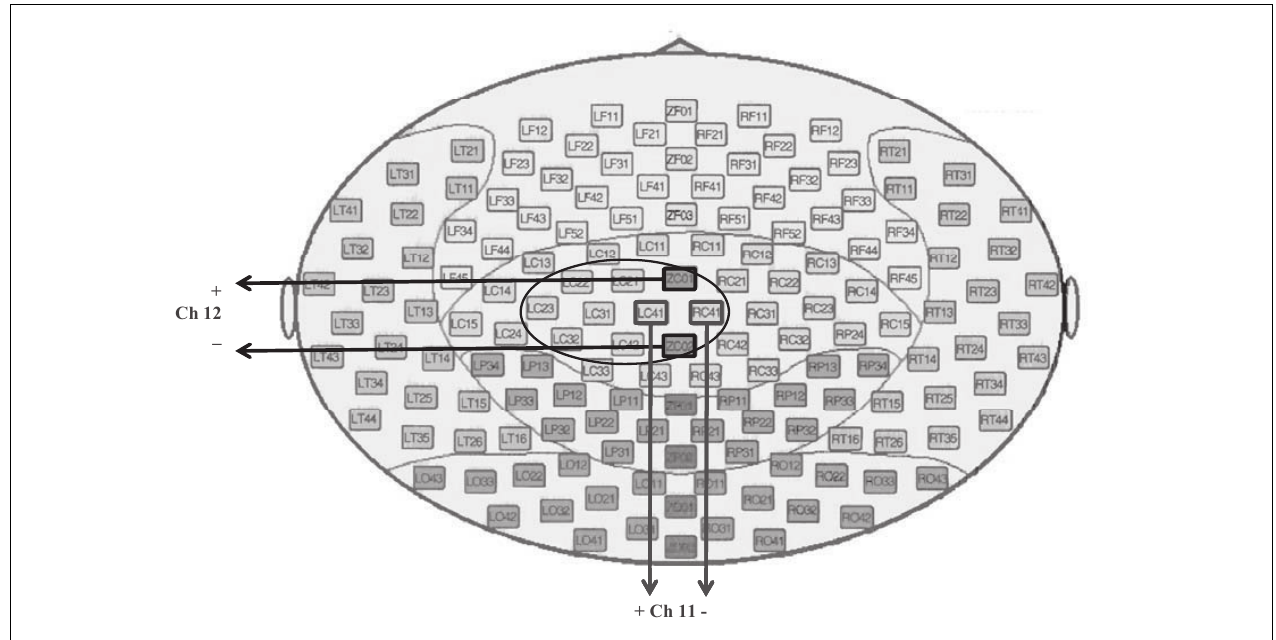
FIGURE 2 |The method of defining two new artificial channels: channel 11 and